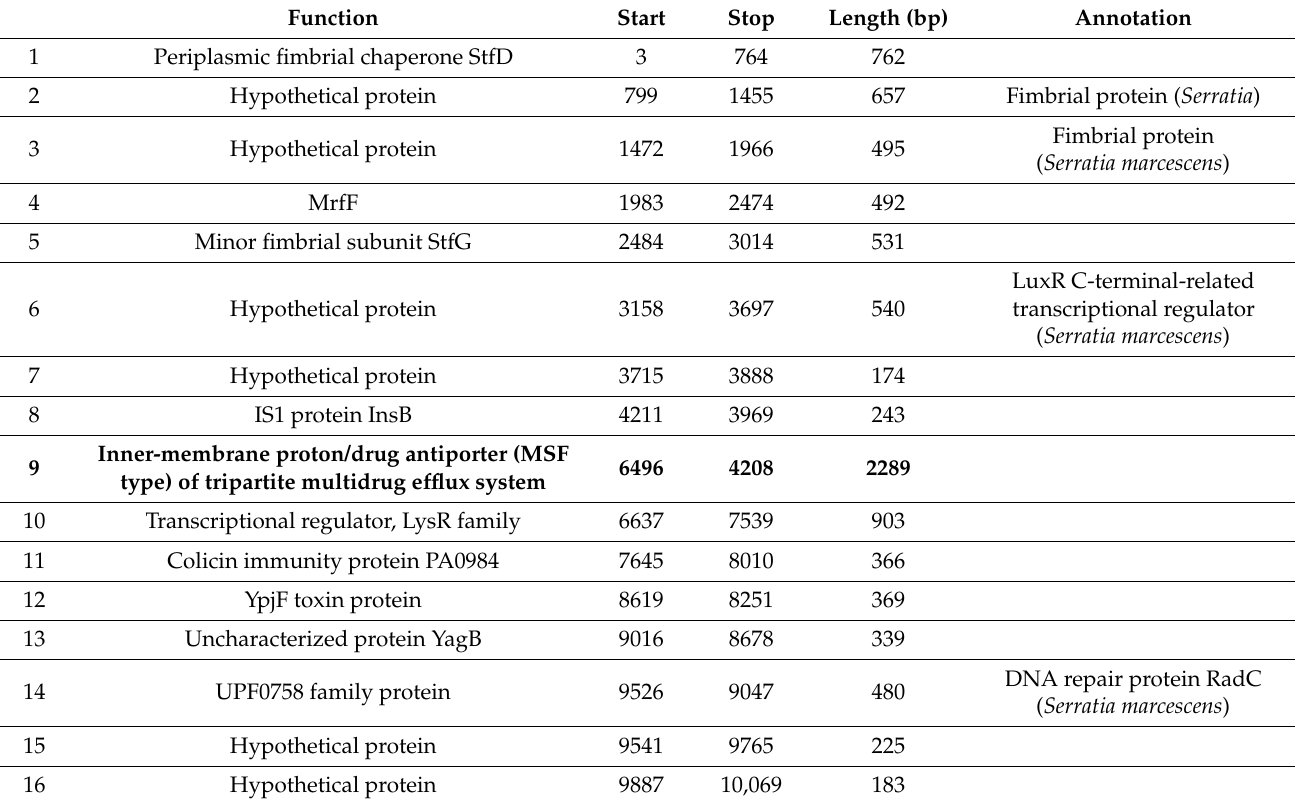
Table 2. Gene list of resistance island 11 of Serratia sp. HRI (1 370 193 bp–1 419 319 bp, GC content 49.2, size 49 126) identified by IslandViewer4. Gene function was annotated via RAST; any hypothetical or uncharacterised proteins were further analysed via NCBI PGAP and BLAST. Annotated drug resistance genes are highlighted in